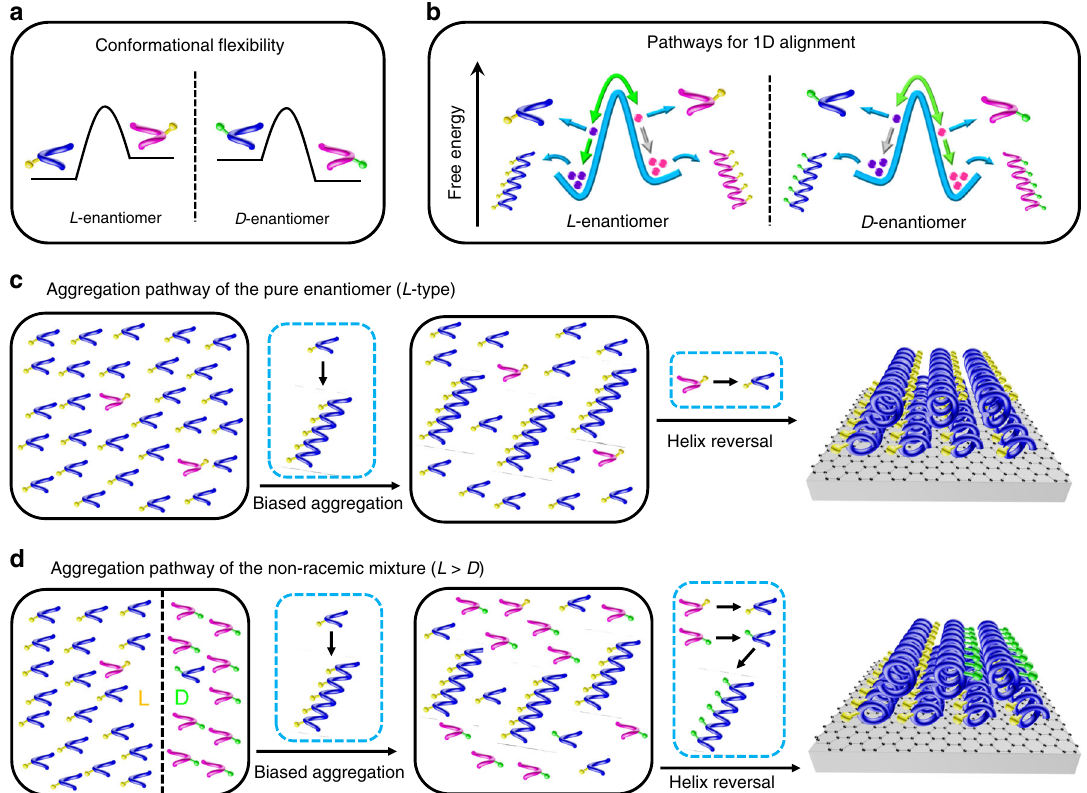
Fig. 1 Pathway complexity in ampli fi cation of chirality. a Monomers of the two enantiomers — their absolute con fi guration is indicated by yellow ( L -enantiomer) and green ( D -enantiomer) dots — can exist in opposite twisting forms (magenta or blue) that are not mirror-image-related. b Two possible pathways of a pure enantiomer that are related to the formation of 1D aggregation of opposite organizational chirality, but only one route is feasible (indicated by green arrows) while the other one is predicted by modeling but not observed by STM observations, and therefore is called an inactive pathway (gray arrows). c Ampli fi cation of chirality in supramolecular bilayers of a pure enantiomer. The formation of homochiral bilayers of the pure enantiomer is initiated by the aggregation of the majority conformer, concomitant with the helix reversal of the minority conformer. d Aggregation pathway of an enantiomerically enriched mixture. The minority enantiomer tends to adopt the less-favored twisted conformation going hand in hand with it self- assembling according to the otherwise inactive aggregation pathway (see above), leading to its incorporation into the handed lattice of the majority